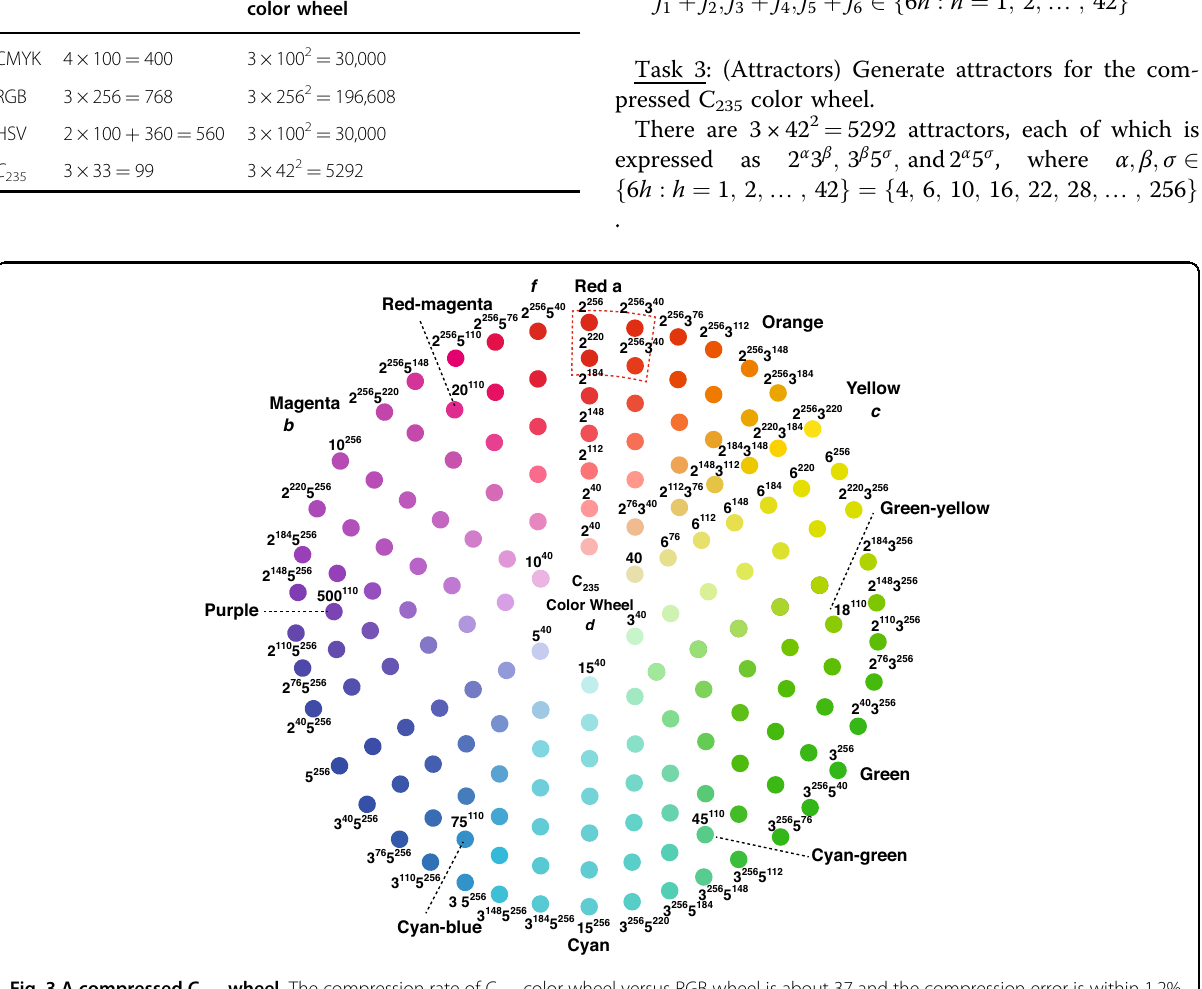
Fig. 3 A compressed C 235 wheel. The compression rate of C 235 color wheel versus RGB wheel is about 37 and the compression error is within 1.2%. With a compressed